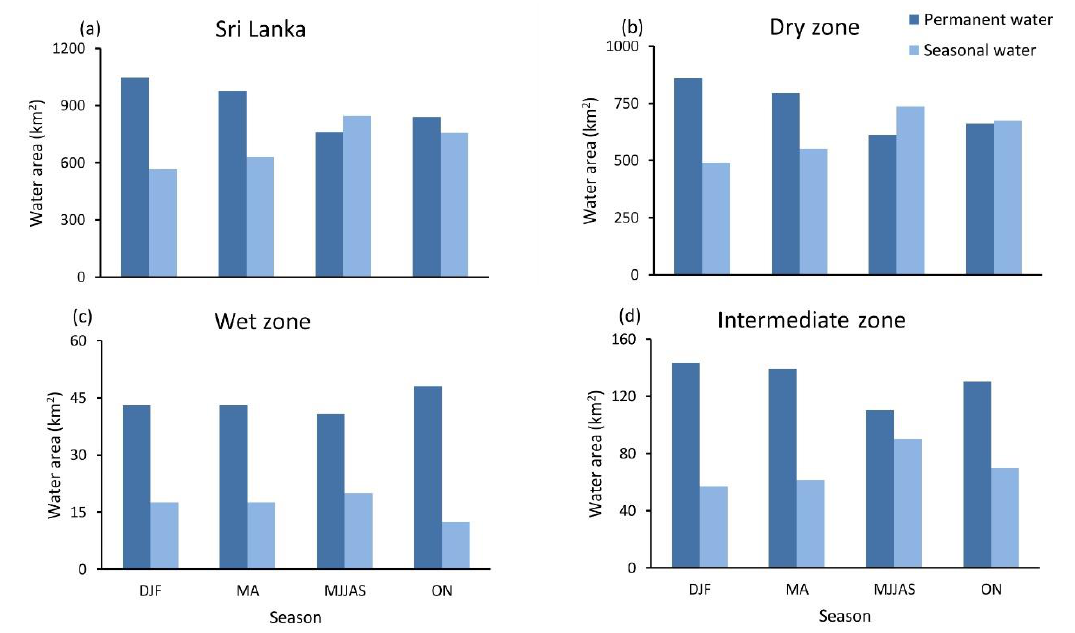
Figure 7. The seasonal variations of surface water area in Sri Lanka. ( a ) Entire country and different climatic zones: ( b ) Dry zone, ( c ) Wet zone, and ( d ) Intermediate zone from 1988 to 2019.